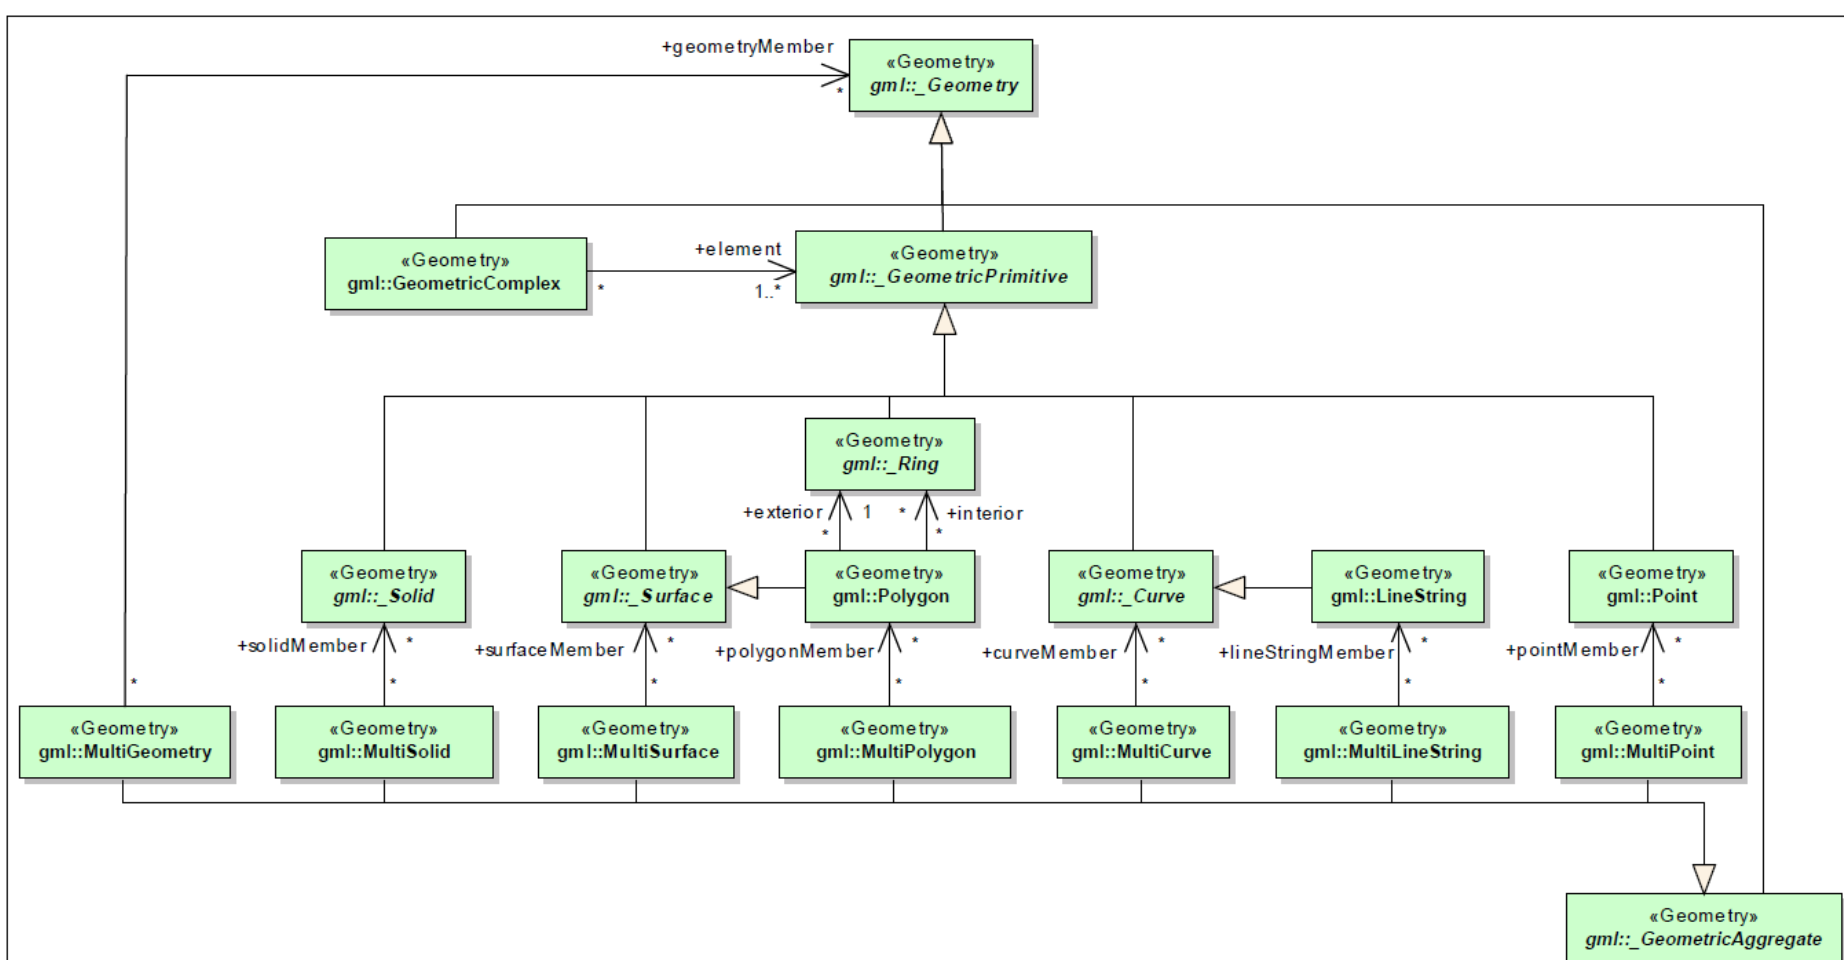
Figure 10. A part of 3DCDM Geometry Model—(profile of